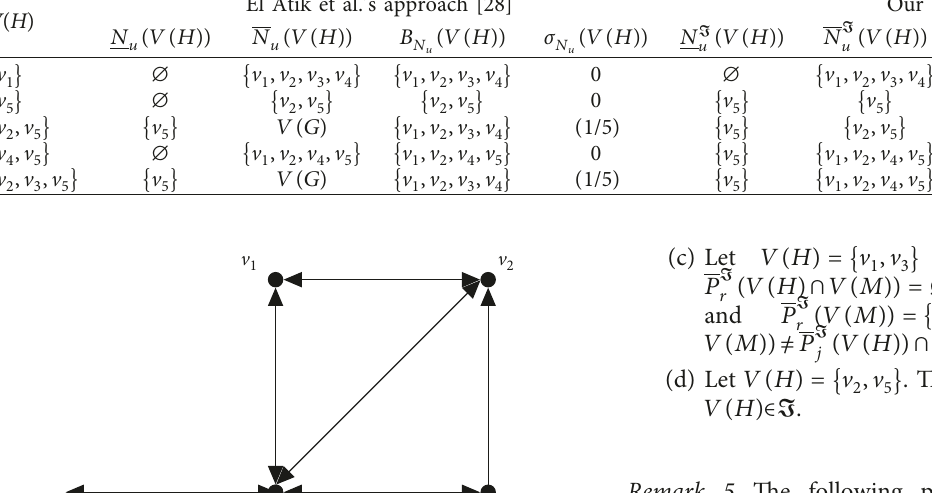
Figure 2: A directed graph G